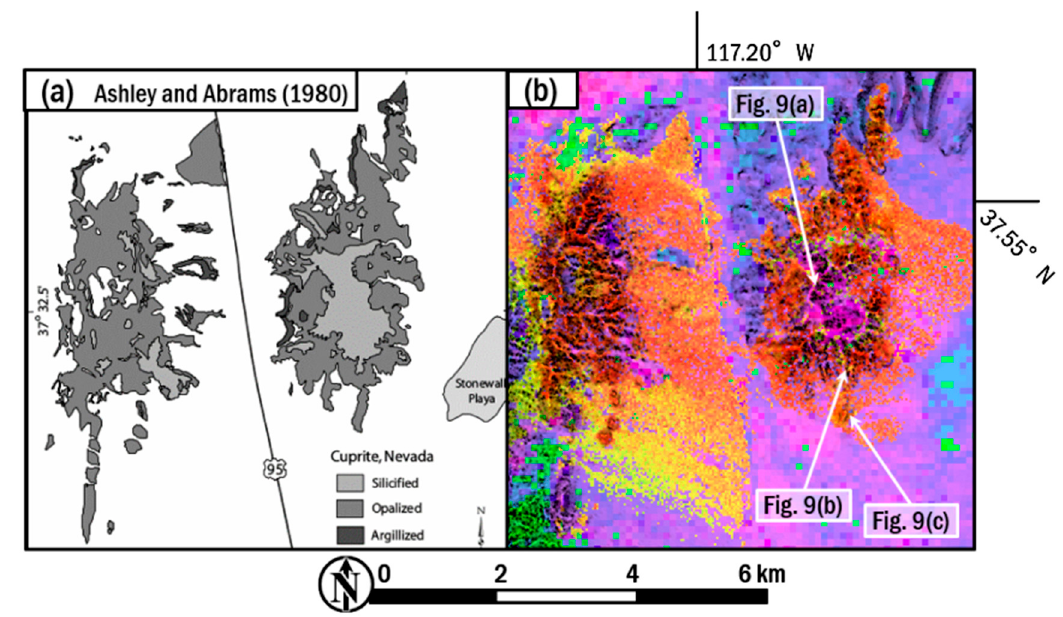
Figure 8. Comparison between ( a ) Zonation of the hydrothermal alteration in Cuprite, Nevada by Ashley and Abrams [20] and ( b ) integrated image.